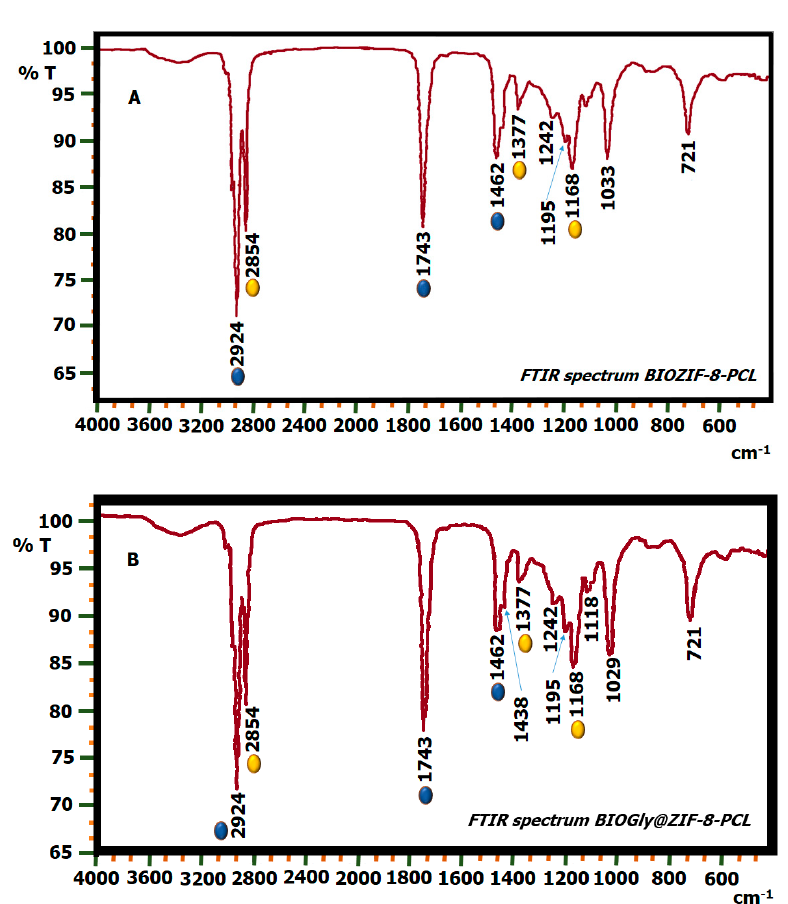
Figure 7. FTIR spectrum of: ( A ) BIOZIF-8 and ( B ) BIOGly@ZIF-8.